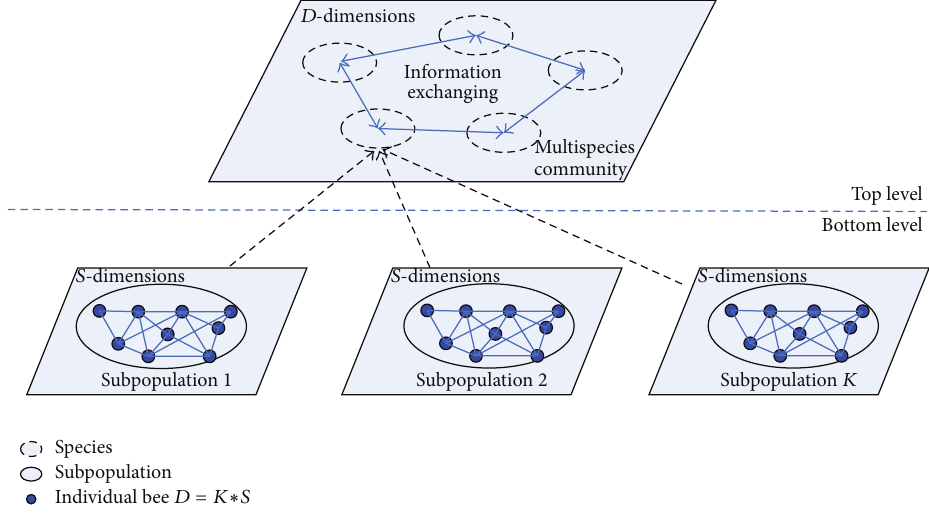
Figure 2: Hierarchical optimization